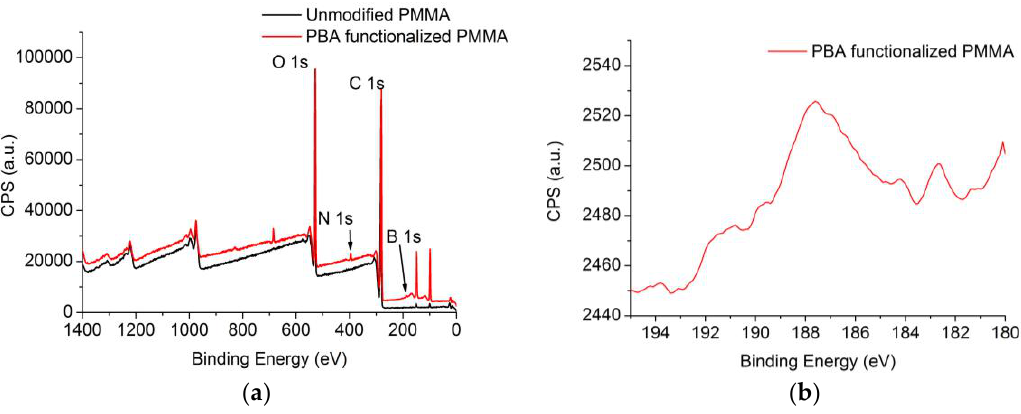
Figure 7. ( a ) General X-ray photoelectron spectroscopy (XPS) spectra of PBA functionalized and unmodified PMMA plain samples; ( b ) high resolution spectra of the PBA functionalized sample for boron 1s. Table 1. Elemental composition of PMMA and PBA functionalized surface from XPS analysis. Sample